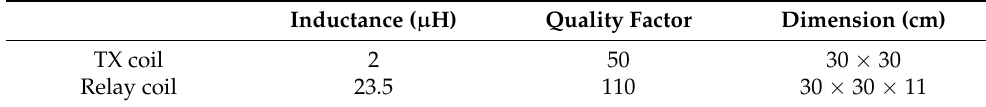
Table 4. Properties of the wireless-charging drawer’s TX coil and relay coil.